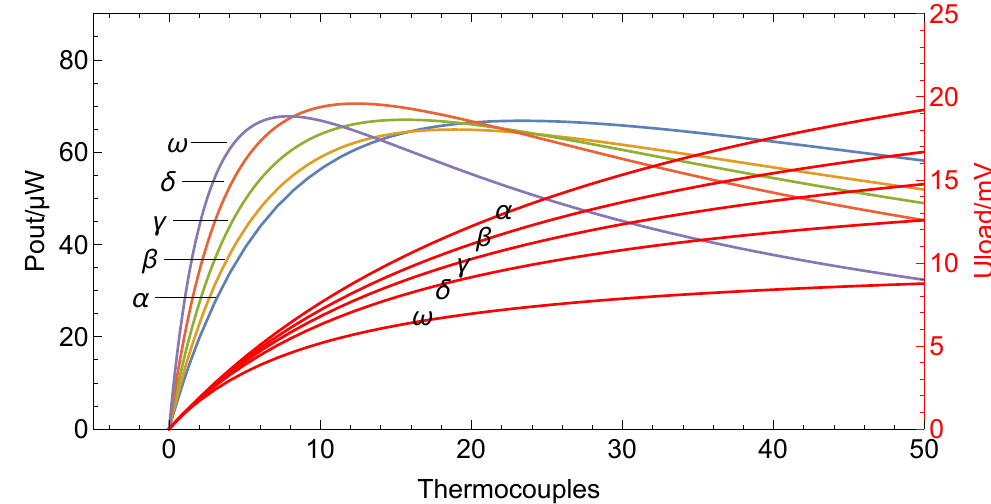
Figure 3. Power output and corresponding open-circuit voltage of TEG for a fin-length of α = 15mm, β = 12mm, γ = 10mm, δ = 8mm, ω = 5mm at a total temperature difference of 5K and resistances of the thermal connections of K h = 35K/W, K c =